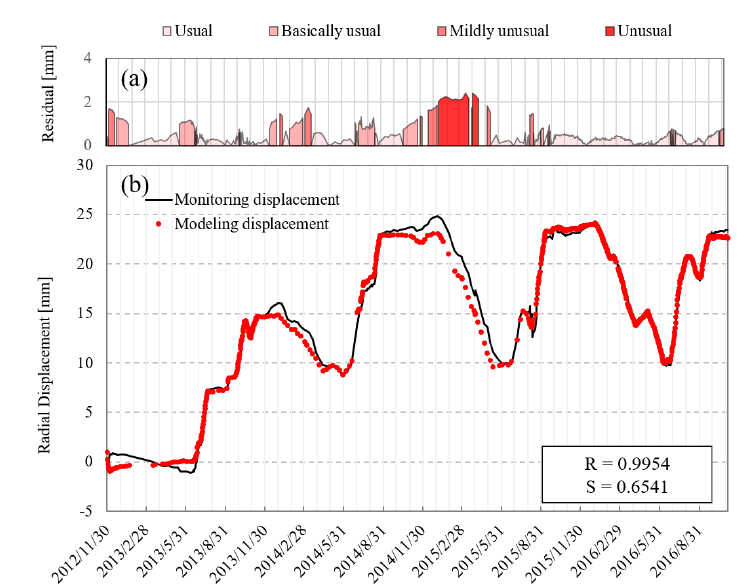
Figure 7. Time variation of ( a ) absolute residual and ( b ) modelled and monitored displacement data for the monitoring point